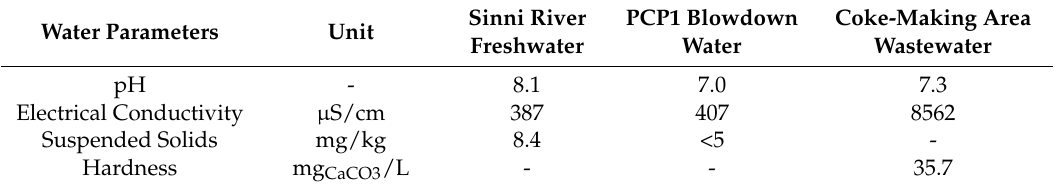
Table 2. Main measured parameters of analysed water streams.